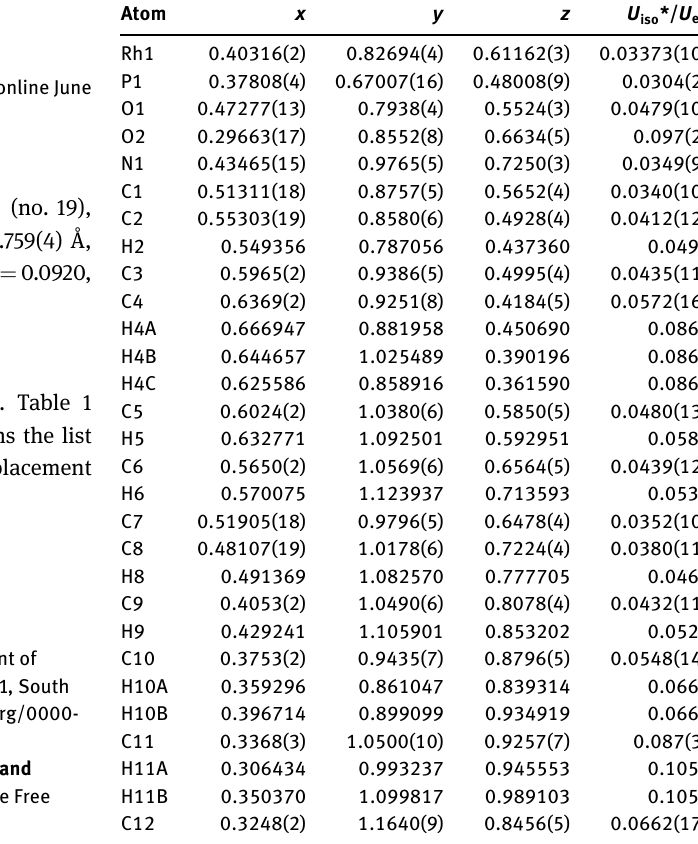
Table 2: Fractional atomic coordinates and isotropic or equivalent isotropic displacement parameters (Å 2